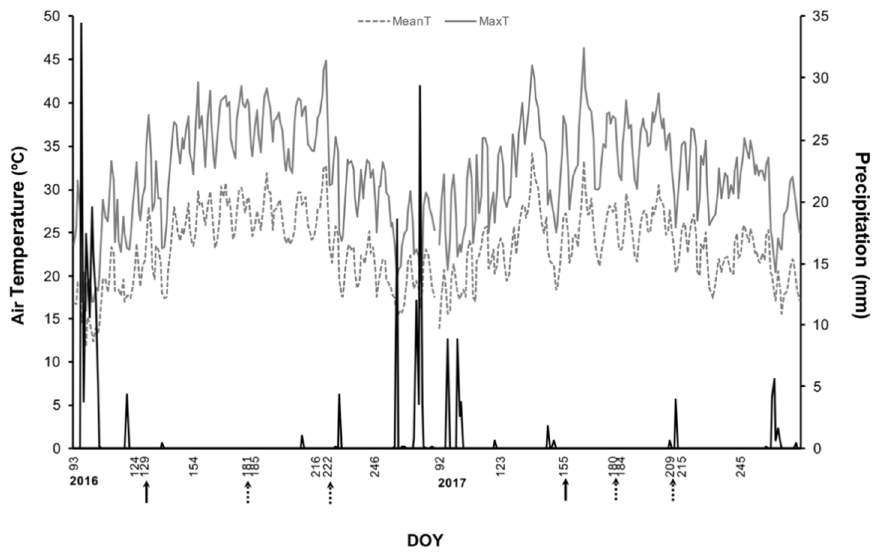
Figure 1. Daily mean temperature (Tmean, dashed grey line), maximum temperature (Tmax, grey line), and precipitation (black line) in 2016 and 2017. The filled arrows show the days of the kaolin application in 2016 (DOY 129) and 2017 (DOY155), and dashed arrows indicate the days of experimental measurements and material collection for prior analysis. DOY: day of the year.